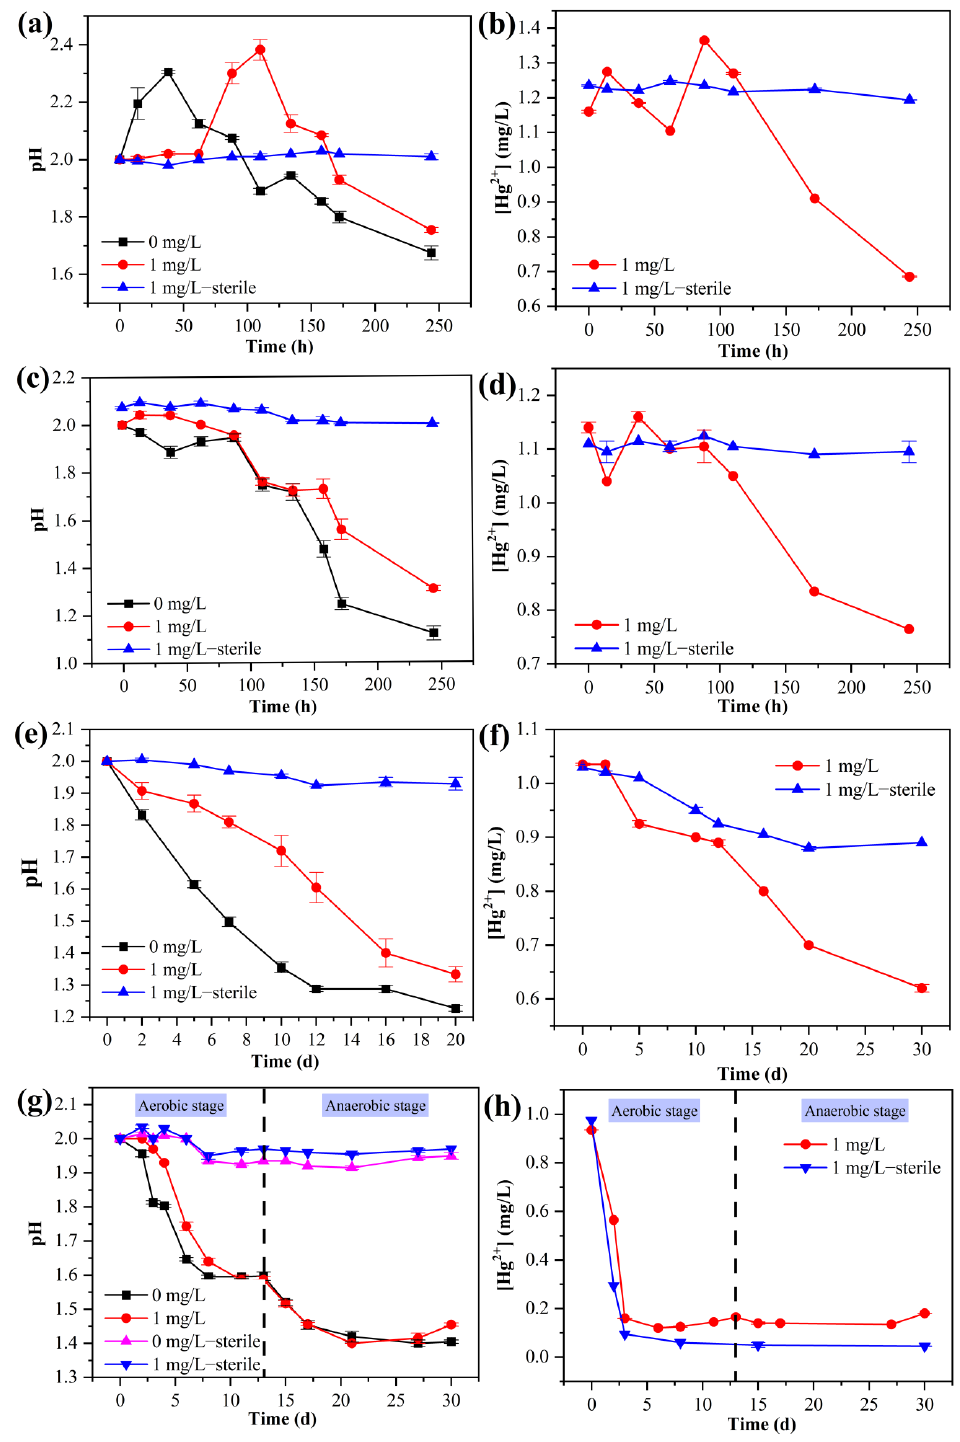
Figure 2. pH value and [Hg 2+ ] for the groups of A. ferrooxidans ATCC 23270 grown with Fe 2+ ( a , b ), S 0 ( c , d ), anaerobic Fe 3+ reduction coupled with S 0 oxidation ( e , f ), and aerobic–anaerobic coupling ( g , h ) with and without the addition of 1 mg/L Hg 2+